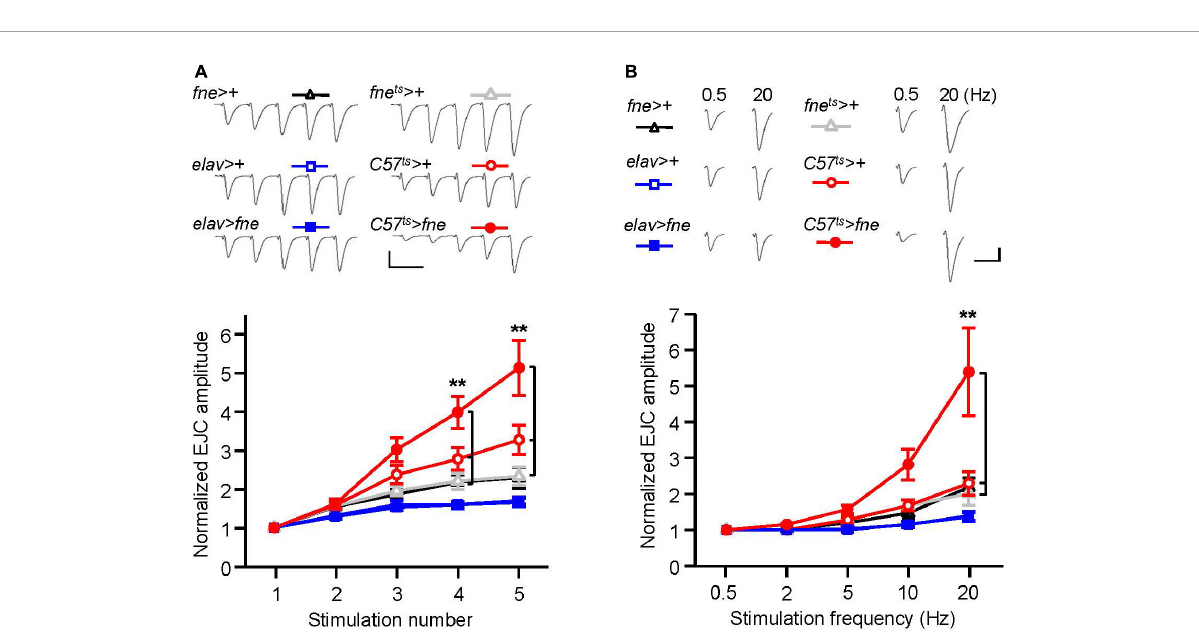
FIGURE6 Overexpression of fne in muscle cells altered short-term synaptic facilitation in the larval NMJ. (A) STF during a short train of repetitive stimulation (25 Hz) in the wild type and in the overexpression of fne strains. Top, representative traces. Bottom, summary of normalized EJC amplitude. (B) STF were determined at the various stimulation frequency (0.5–20 Hz) in the control and in the overexpression of fne strains. Top, representative traces of the EJCs for 0.5 and 20 Hz in the indicated genotypes. Bottom, summary of normalized EJC amplitude. The C57 ts > fne , C57 ts > +, and fne ts > + flies were reared at 18 ◦ C and shifted to 29 ◦ C for 1 day to induce fne expression. Calibration: 10 nA, 50 ms. n = 8 for each group. Error bars represent SEM. ** p <